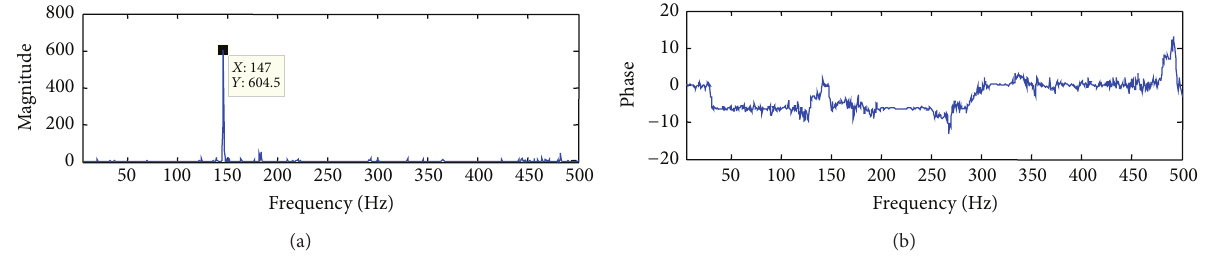
Figure 9: Fictitious frequency response function in the case of a fault on the inner race of the ball bearing: (a) magnitude spectrum and (b) phase spectrum.